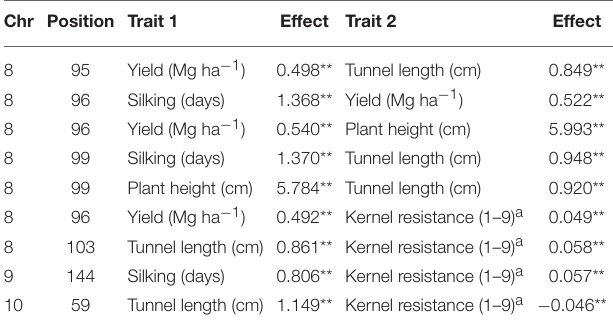
TABLE 4 | Joint list of QTL from the Join analysis using LOD score > 5.8 (90% of confiability) mapped in the RIL population derived from A637 × A509 evaluated in a 2 year experiment under MCB